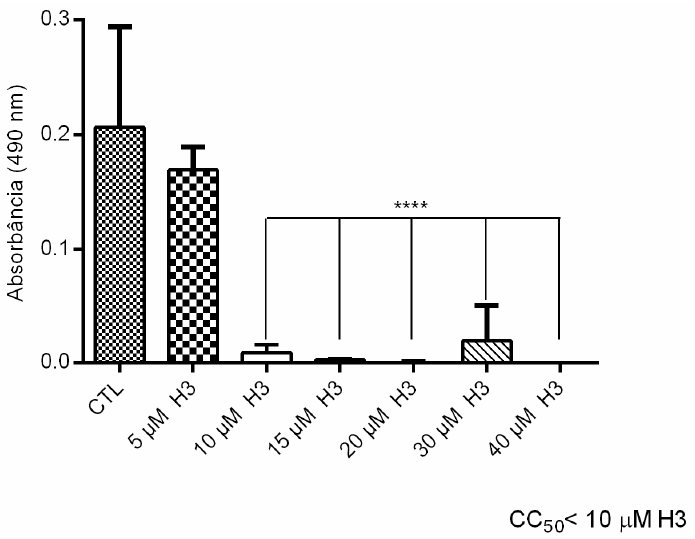
Figure 5. Cell cytotoxicity assay during the treatment of murine macrophages with different concentrations of H3 . The CC 50 value obtained was higher than 5 µM. One-way ANOVA with Dunnett’s post hoc test was used for statistical analysis. **** p < 0.0001.